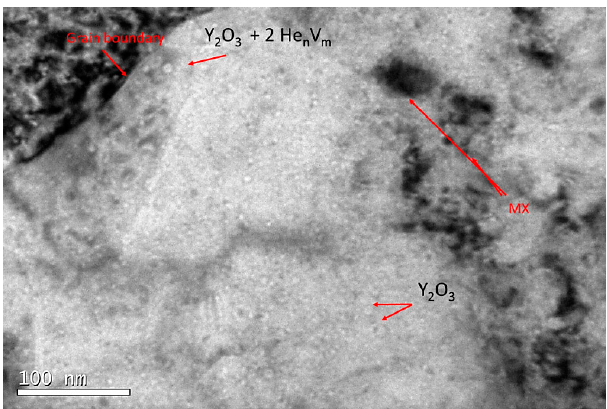
Figure 13. TEM micrograph belonging to zone B (548–619 appm He) of EU-ODS EUROFER steel annealed at 450 °C for 100 h. A grain boundary and two MX type precipitates are highlighted with no clear indication of cavities in their surrounds. In addition, two yttria particles with no cavities along with another one with two cavities attached are also pointed out.